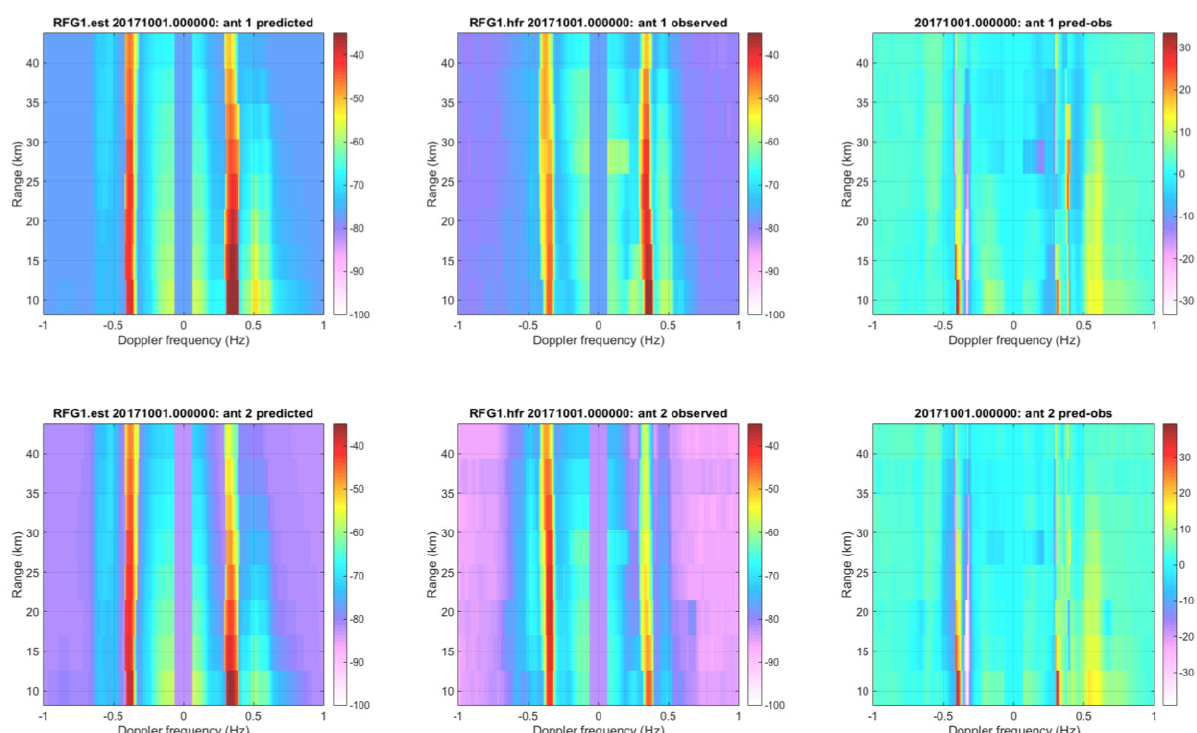
Figure 3. Range Doppler plots for the RFG1 HF radar site antennas 1 and 2 on 1 October 2017 at 0000z. The left plots are the predicted fields from the SWAN HF Doppler model. The center plots are the observed HF radar data. The right plots denote the difference between the first two fields. The first- and second-order Bragg peaks are visible in both the predicted and observed range Doppler